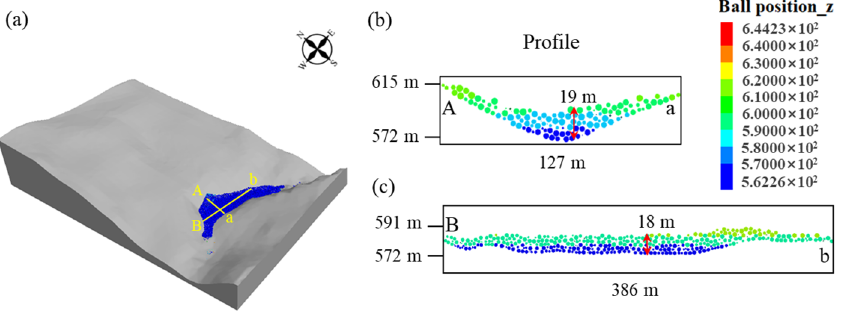
Figure 16. The transverse and longitudinal slices of the landslide dam: ( a ) the simulated geometry of the landslide dam, ( b ) the transverse slice along the A-a section of the landslide dam, ( c ) the longitudinal slice along the B-b section of the landslide dam.